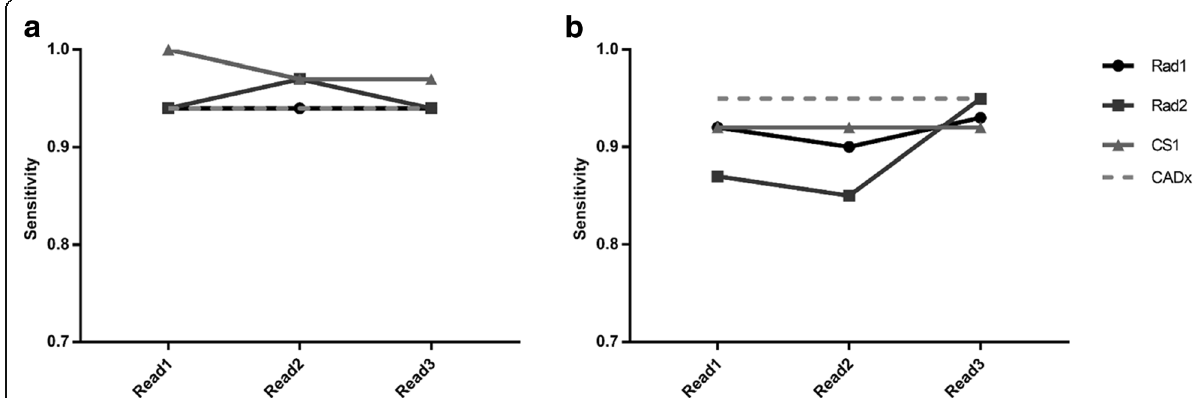
Fig. 4 Sensitivity figures for the three image reads. Sensitivity figures for the three image reads, for local data ( a ) and PPMI data ( b ). Standalone CADx performance is also shown, for comparison